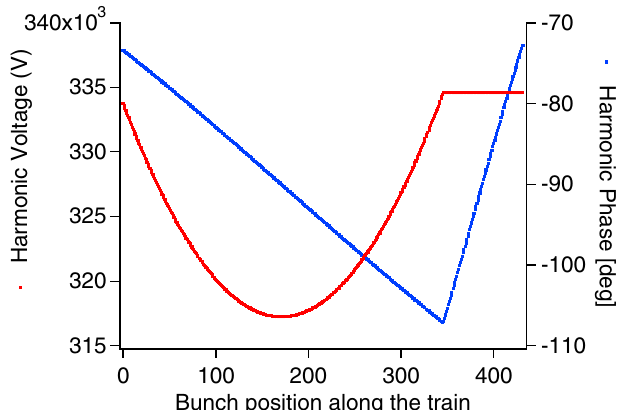
FIG. 8. (Color) ESRF code results of the harmonic voltage (red) and phase (blue) modulation along the bunch train after the transient beam loading, obtained for a beam current of 315 mA, a 80% filling and a 3HC detuning of (cid:7) 144 kHz .